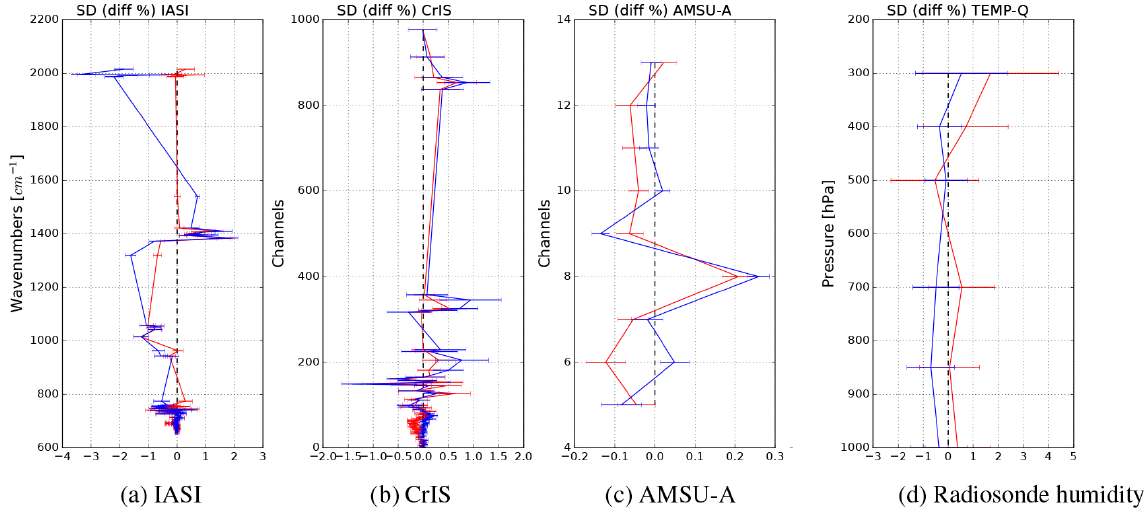
Figure 8. Relative differences of FG departure (red curve) and AN departure (blue curve) standard deviation between EXP and REF for IASI (a) , CrIS (b) , AMSU-A (c) and TEMP-q (d) . The horizontal error bars represent the 95% significance value for each